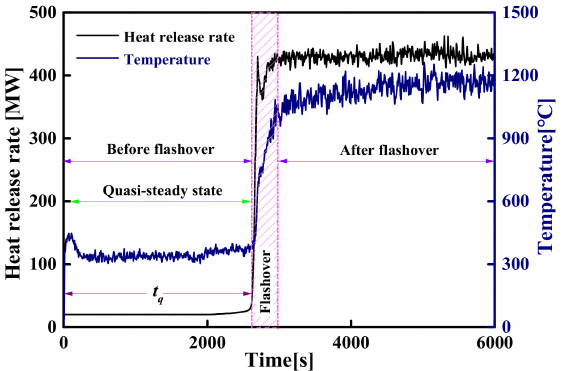
Figure 20. The evolution of the HRR and temperature over time in a flashover fire.